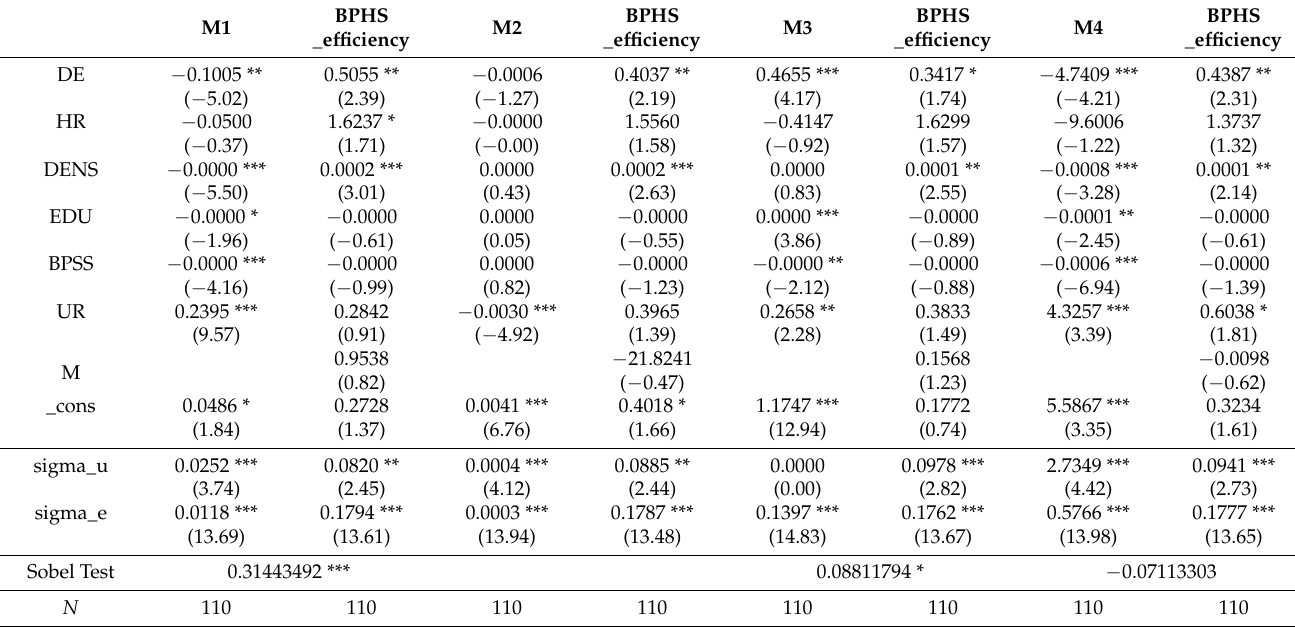
Table 9. Estimated results of mediation